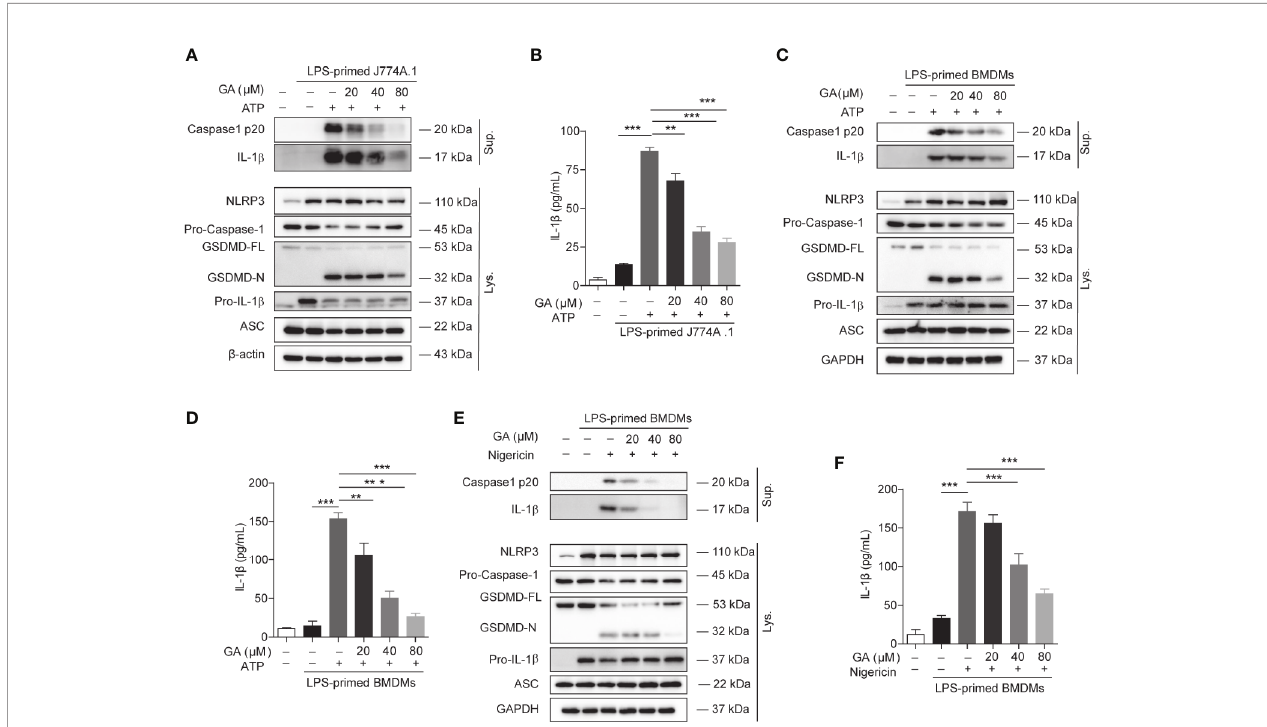
FIGURE 2 | Gallic acid inhibits NLRP3 in fl ammasome activation and pyroptosis in murine macrophages. (A, B) Lipopolysaccharide (LPS)-primed J774A.1 cell were stimulated with ATP for 1 h in the presence or absence of gallic acid. (C – F) LPS-primed BMDMs were incubated with gallic acid for 30 min and then stimulated with ATP (C, D) or nigericin (E, F) for 1 h. Supernatants (Sup.) and cell extracts (Lys.) were analyzed by immunoblotting (A, C, E) , and IL-1 b release in supernatants was also analyzed by ELISA (B, D, F) . GA, gallic acid. * P < 0.05, ** P < 0.01, *** P <